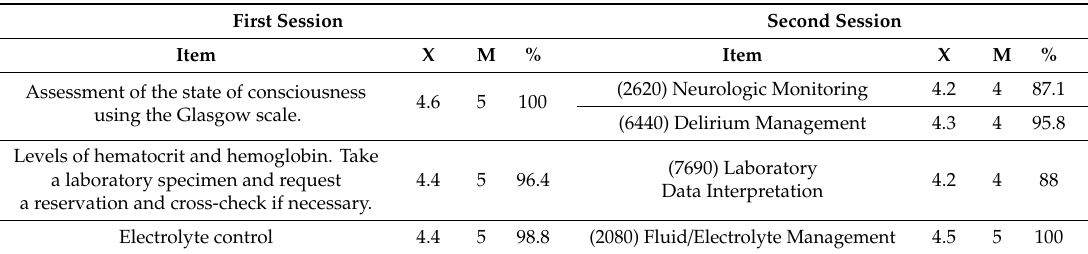
Table 1. Examples of suggested interventions that were contained in the nursing interventions classification